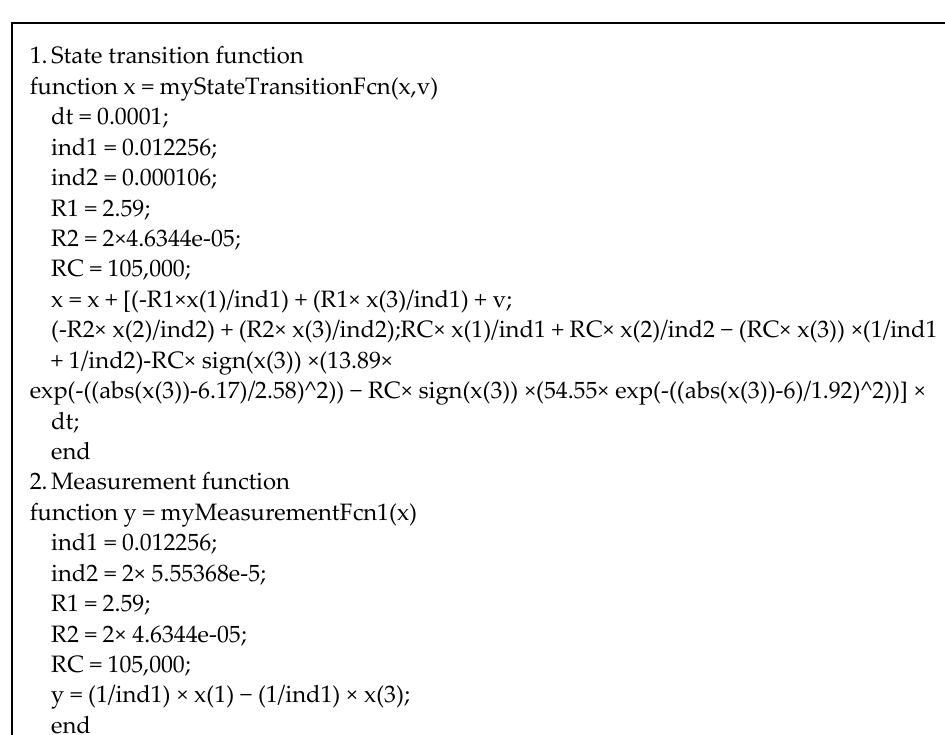
Figure 14. Simulink model of the EKF for primary current